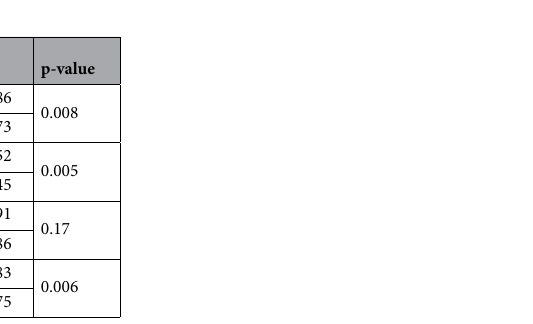
Figure 4. ( A ) Distribution of the accuracies obtained in 10-fold cross-validation by applying k-NN and CSOM algorithms on wines database. ( B ) Example of a mapped CSOM in which the probability of the six non- conclusive examples reported by the algorithm are shown. Interestingly, true class is the one with the higher probability in all the examples, although it is not enough to achieve the threshold value (t > 0.5).